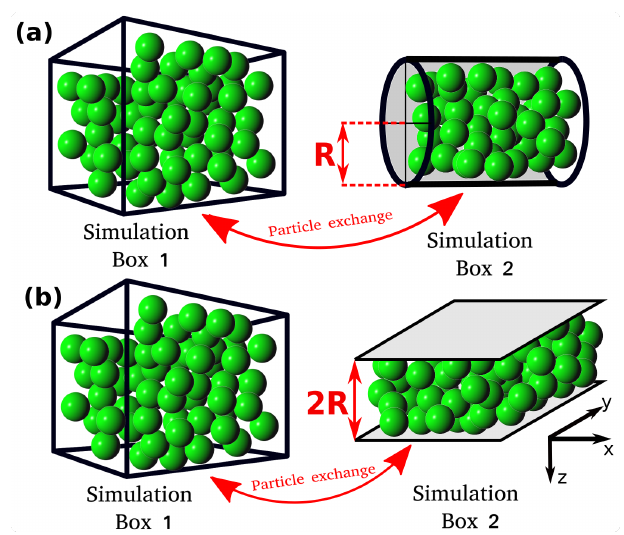
Figure 1. Schematic representation of the Monte Carlo (MC) simulation scheme. Simulation Box 1 represents the bulk fluid with differential pressure P . Simulation Box 2 contains the confined fluid with (average) integral pressure (cid:104) ˆ p (cid:105) . ( a , b ) The two investigated systems are shown where the bulk fluid is in equilibrium with the nanoconfined fluid in a cylinder and in a slit pore, respectively. Due to the particle exchange, the chemical potential of the two boxes are equal, but in general P (cid:54) = (cid:104) ˆ p (cid:105)